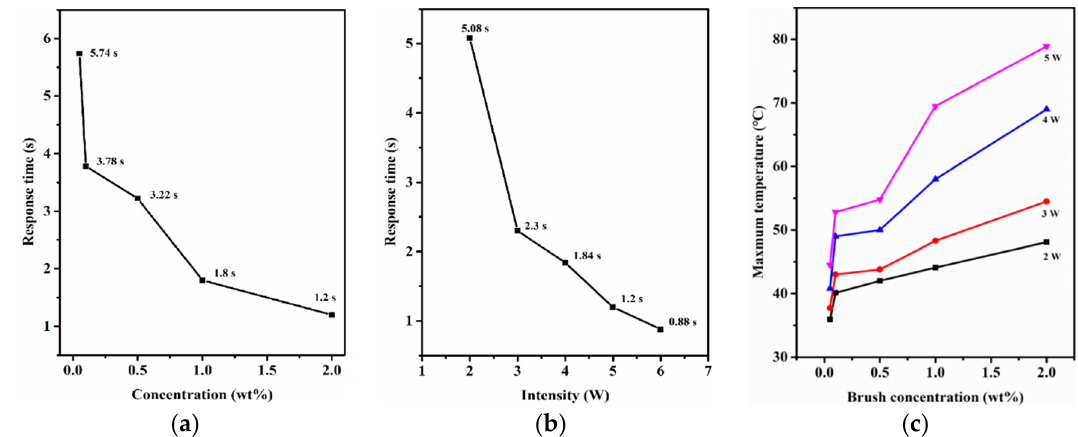
Figure 8. ( a ) The relationship between response time and polymer brush concentration ( b ) The relationship between response time and NIR radiation intensity. ( c ) Maximum temperature rise of PSLC cells with different polymer brush concentrations under different light intensities.